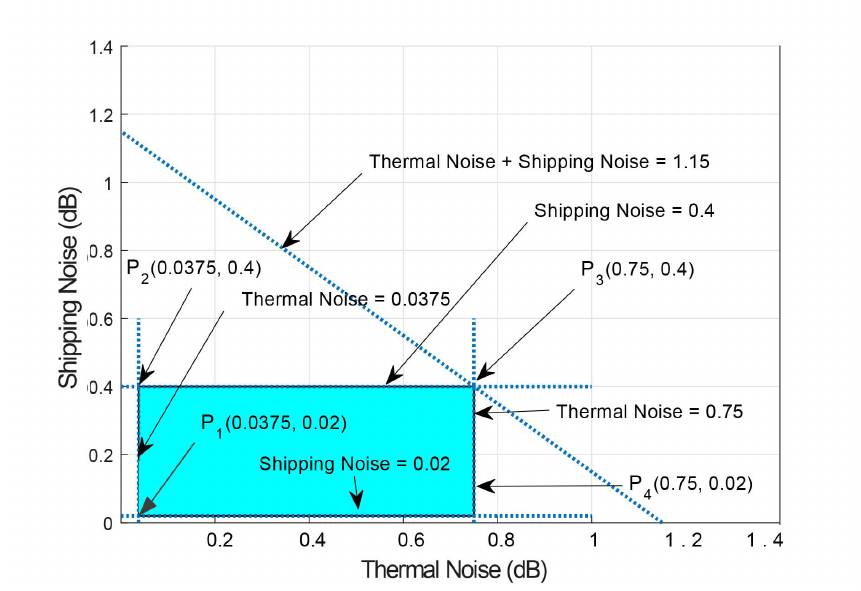
Figure 15. Feasible Region for Noises in UWSNs.